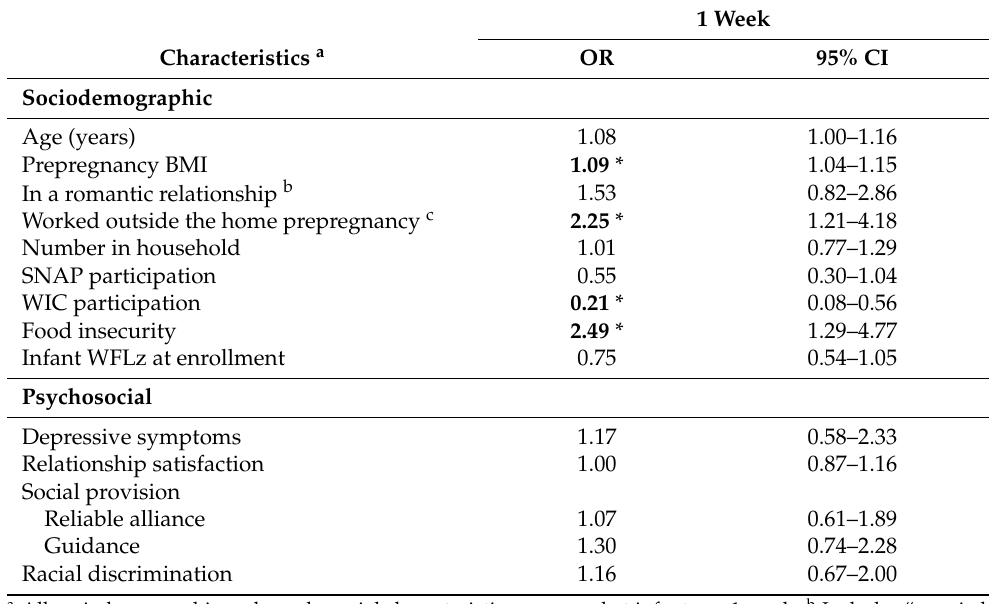
Table 2. Bivariate logistic regression models for associations between select sociodemographic and psychosocial characteristics and any breast milk feeding at infant age 1 week among African American mothers ( n = 185).